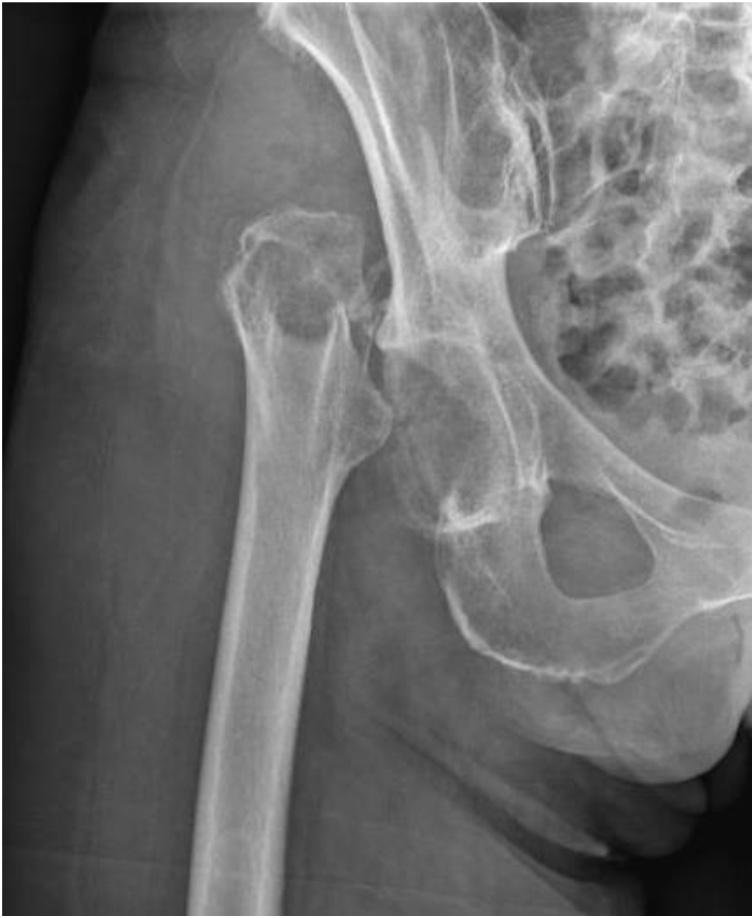
Plain X-ray after removal of the total hip arthroplasty. A prosthesis-free interval of 6 weeks was performed.